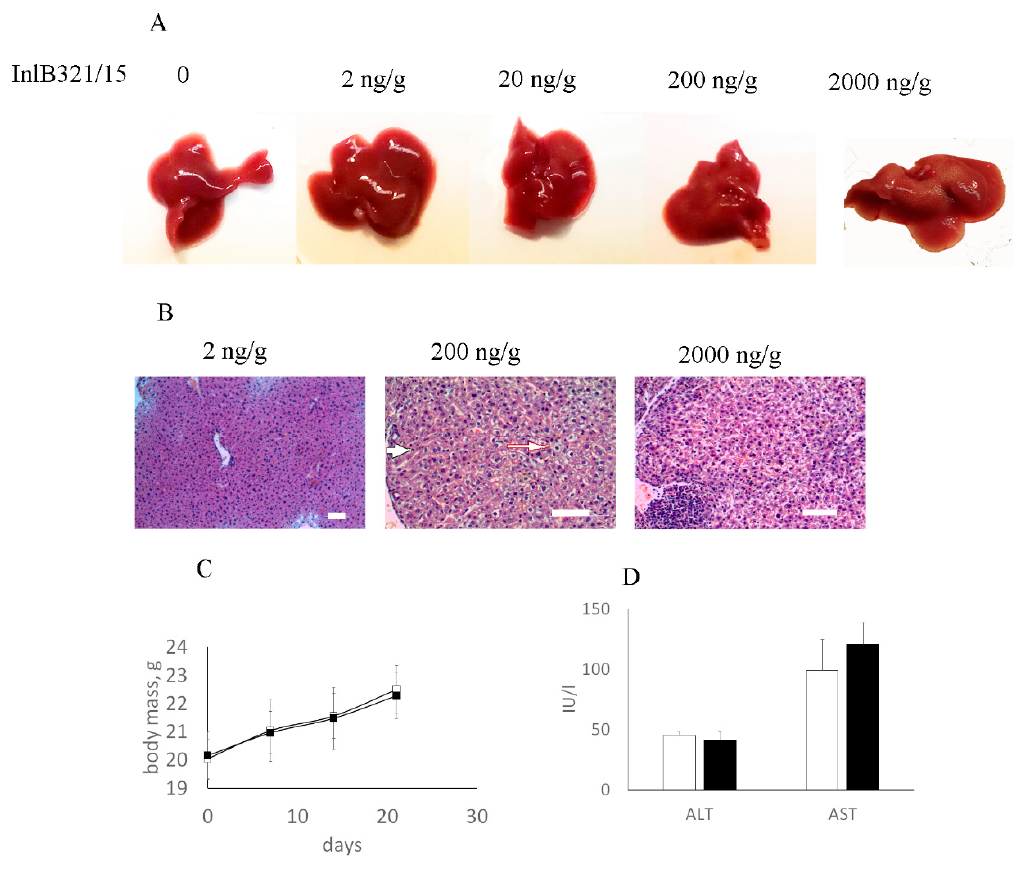
Figure 2. InlB321 / 15 toxicity assay in BALB / c mice. ( A , B ) Mice were injected with vehicle (PBS) or decimal dilutions of InlB321 / 15 (2–2000 ng per g of animal weight, g − 1 ). The liver was taken for macroscopic ( A ) and pathohistological ( B ) examination at 48 h post treatment. The arrow shows dystrophic changes in the livers of animals that were given 200 and 2000 ng · g − 1 InlB321 / 15; scale bar 100 µ m. ( C , D ) A quantity of 2 ng · g − 1 InlB321 / 15 was injected twice a week for 3 weeks; body masses were measured weekly ( C ); at the end of experiment, serum was taken to measure the injury markers amino transferase (ALT) and aspartate amino transferase (AST) ( D ).